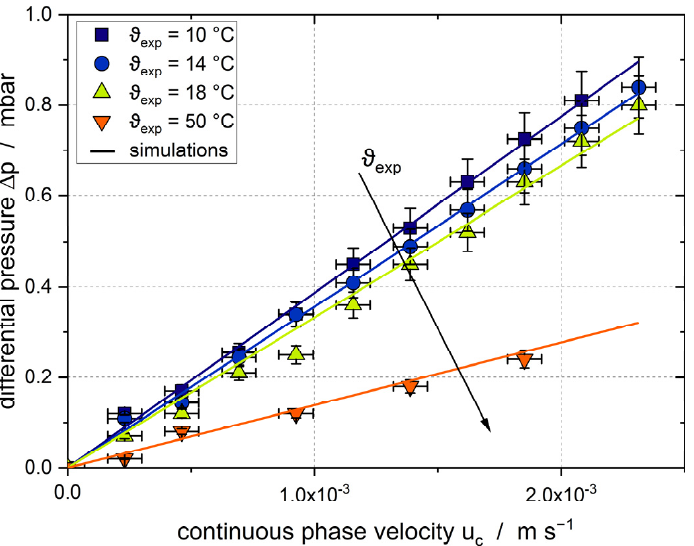
Figure 6. Experimental and simulated differential pressure values for the rectangular microfluidic channel with pure water at temperatures ϑ exp between 10 ◦ C and 50 ◦ C flowing through it.